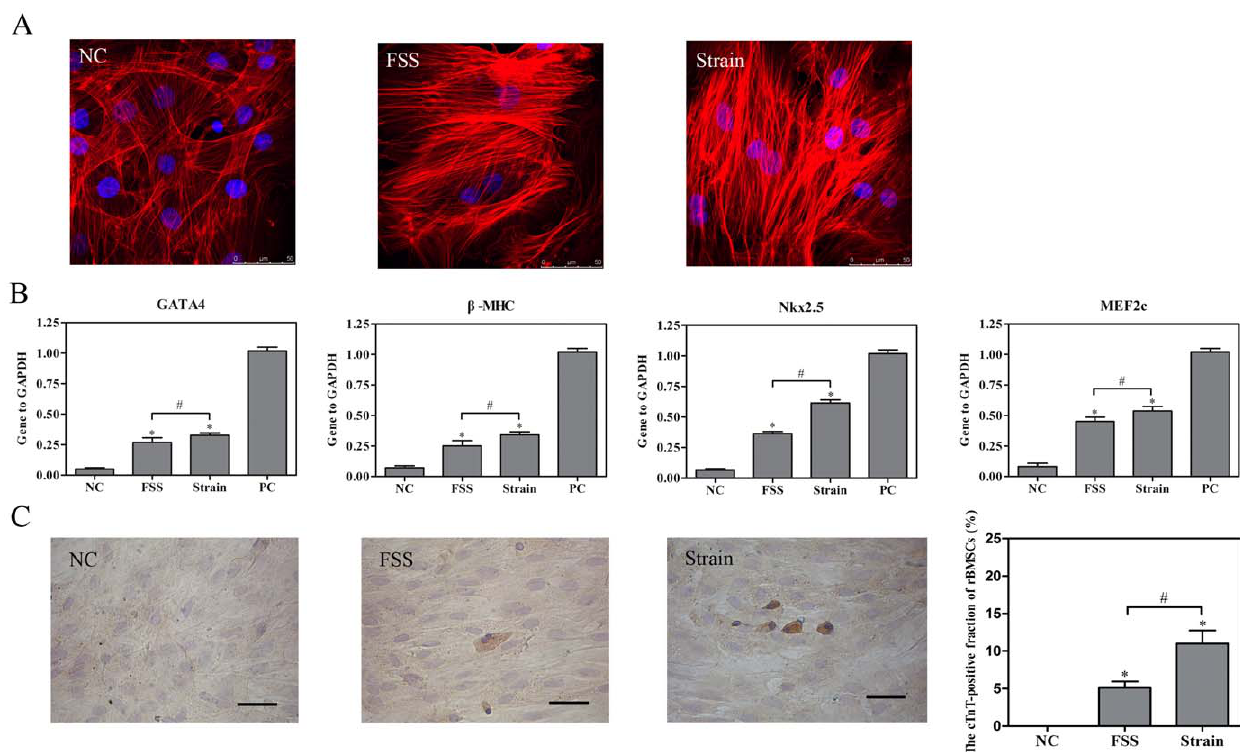
Figure 6. Effects of cyclic strain or FSS on cardiomyogenic differentiation of rBMSCs. rBMSCs cultured under static conditions, exposed to shear stress of 10 dyne/cm 2 or exposed to cyclic strain of 10% at a frequency of 1 Hz for 24 h. (A) rBMSCs were incubated in Texas red isothiocyanate- conjugated phalloidin to stain all F-actin filaments (red) and with DAPI to label the nuclei (blue). Shear stress and strain were in left R right direction. Scale bar, 50 m m. (B) mRNA expression levels of GATA-4, b -MHC, NKx2.5 and MEF2c were assessed on the 7 th day by quantitative real-time RT-PCR analysis. (C) The expression of cTnT was assessed using indirect immunofluorescence staining on the 14 th day. Scale bar, 50 m m. NC, negative control (rBMSCs treated with regular complete medium); PC, positive control (normal neonatal rat cardiomyocytes). Results are shown as the mean 6 SD values (n=3). * P , 0.05 compared to the NC group; # P , 0.05.